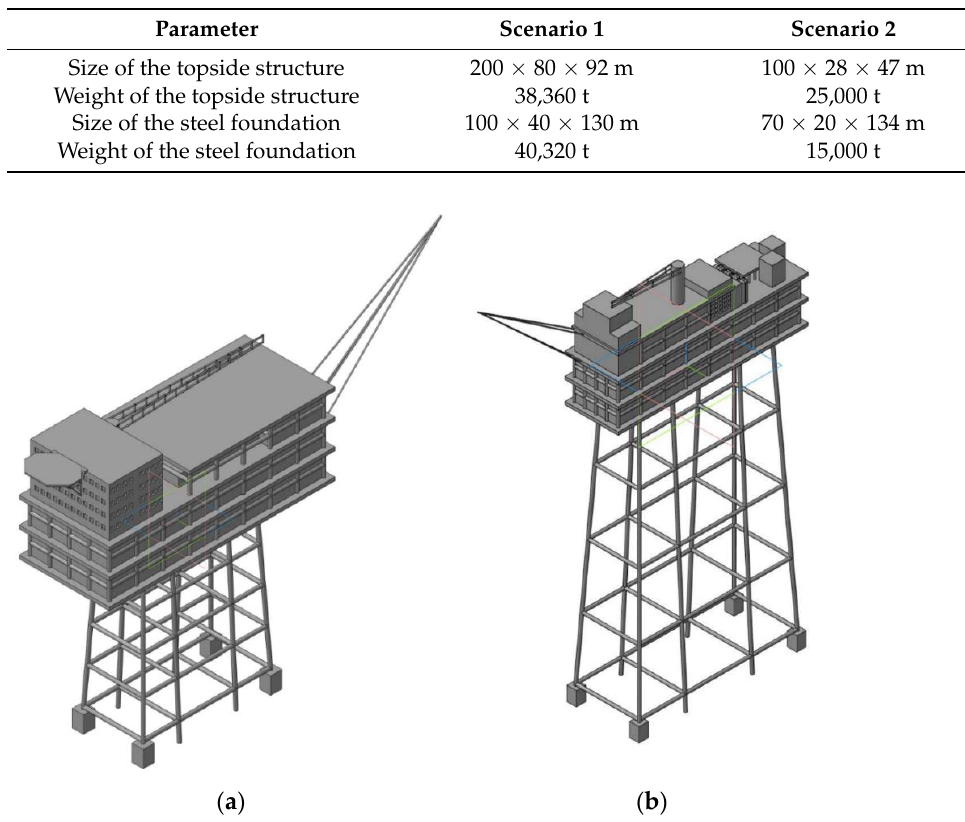
Figure 6. The 3D-models of platforms: ( a ) Scenario 1; ( b ) Scenario 2.